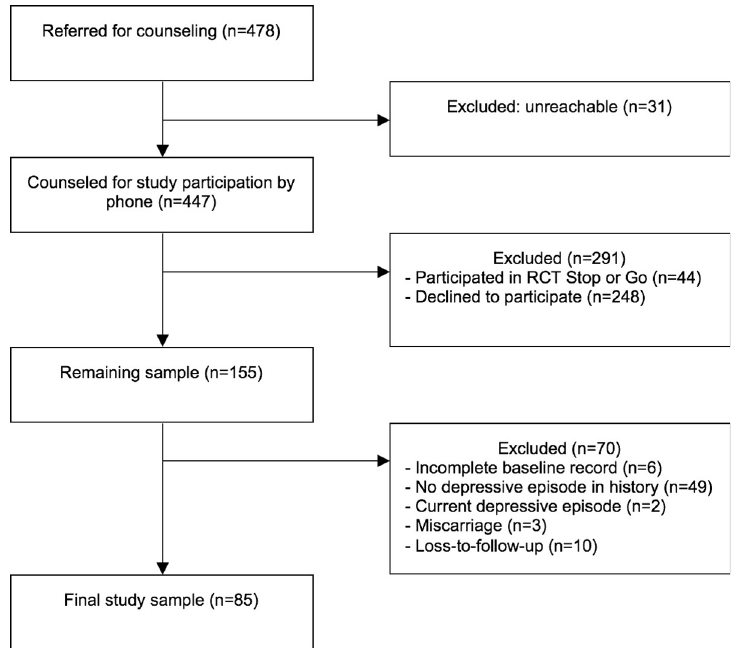
Fig 1. Flowchart of inclusion of